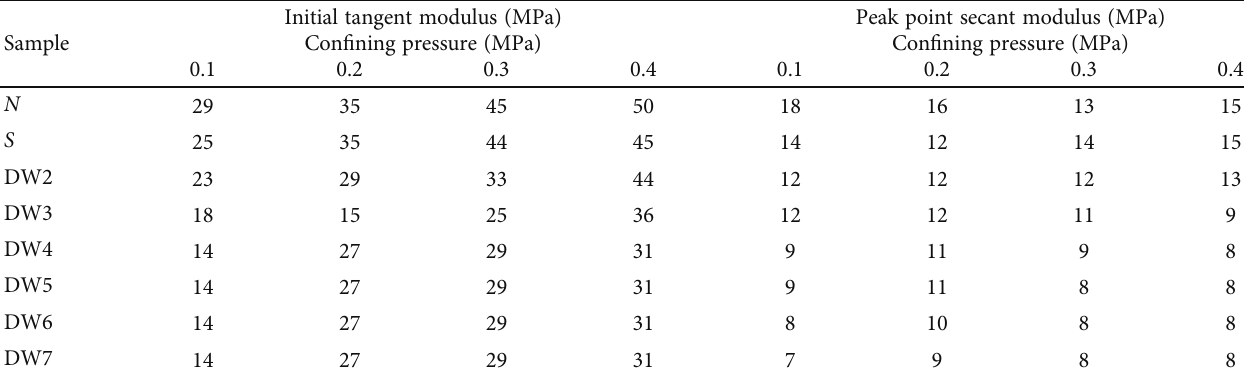
Figure 8: Typical deviatoric stress – strain and volumetric strain – strain curves. Table 2: Initial tangent modulus and peak point secant